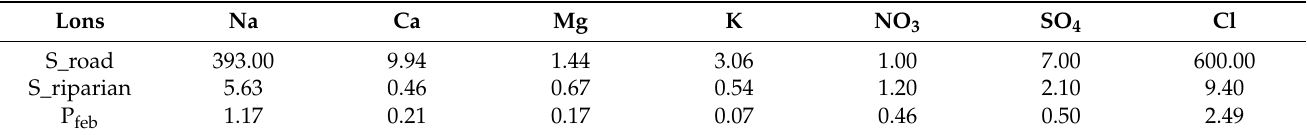
Table 2. Maximum ion concentrations (mg L − 1 ) in the snowpack samples collected in February 2022: S_road—samples taken 1–2 m below the road, S_riparian—samples taken from the riparian